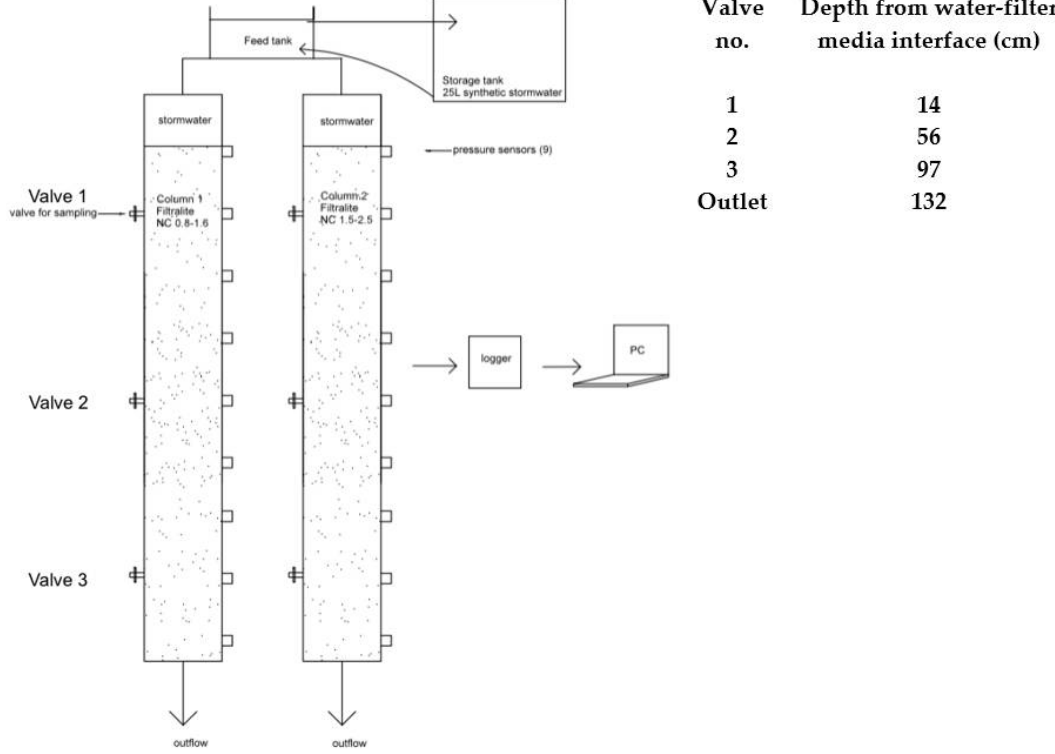
Figure 1. Setup of the column filtration experiment and sampling valve depths.